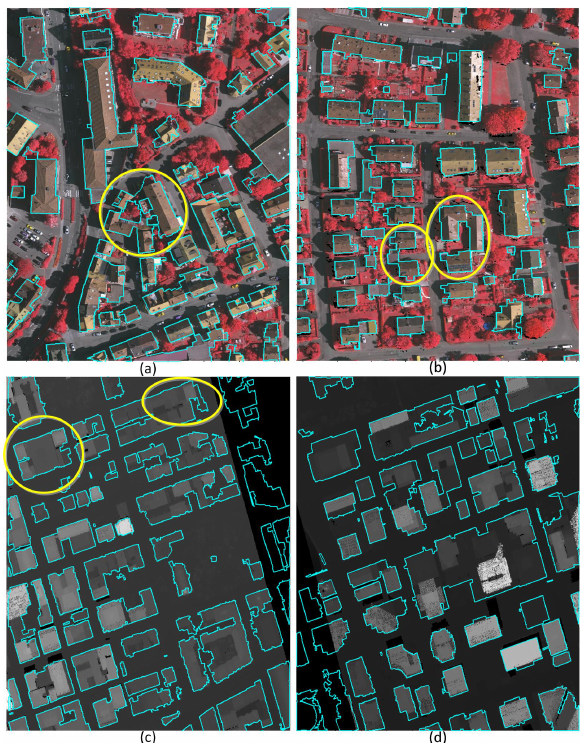
Figure 8: Building footprints overlaid on orthoimagery or on dig- ital surface models: (a) Area 1, (b) Area 3, (c) Area 4 and (d) Area 5. Yellow coloured ellipses show examples of merged